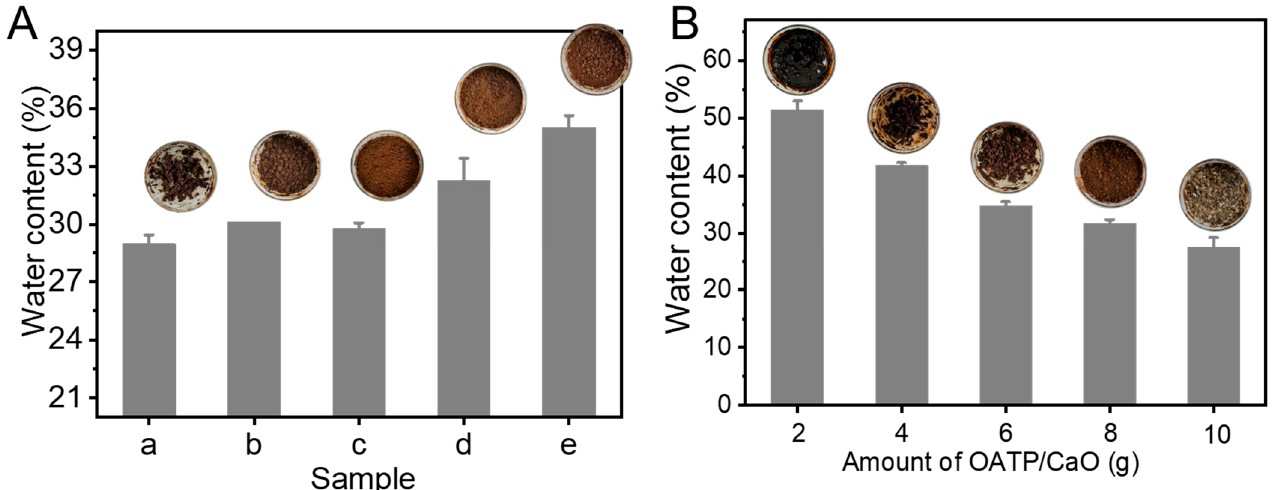
Figure 1. Influence on water content of TWL of different samples at 30 °C: ( A ) ATP/CaO (8.0 g) with different W ATP :W CaO of (a) 0:1, (b) 1:3, (c) 1:1, (d) 3:1, and (e) 1:0; ( B ) OATP/CaO with different amounts.